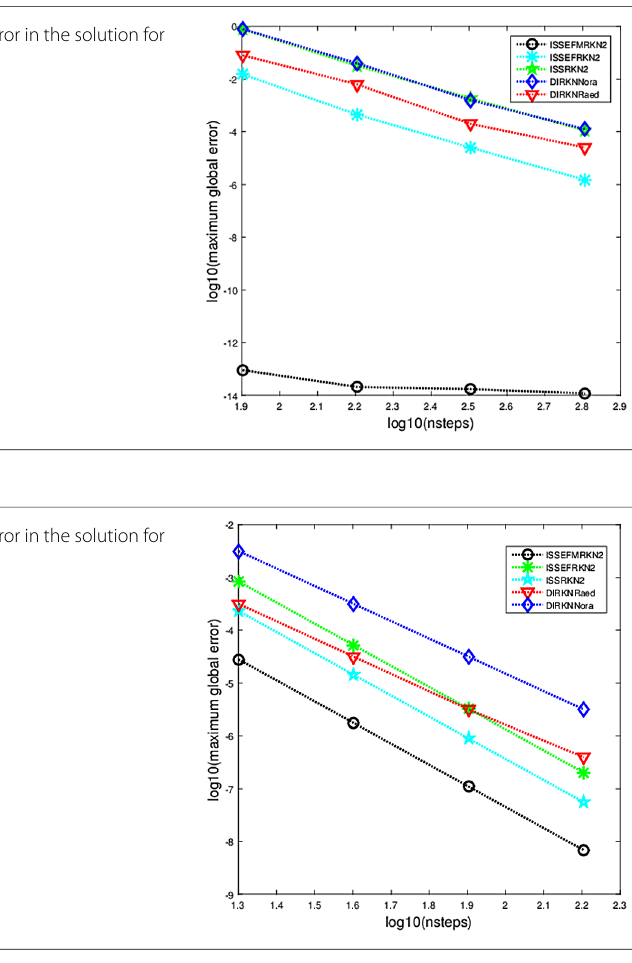
Figure 4 Maximum global error in the solution for Problem 3 with λ = i